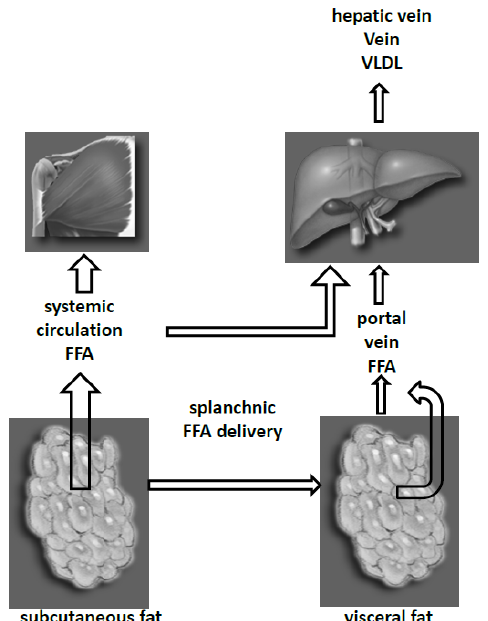
Figure 1. FFA Delivery from Body Fat